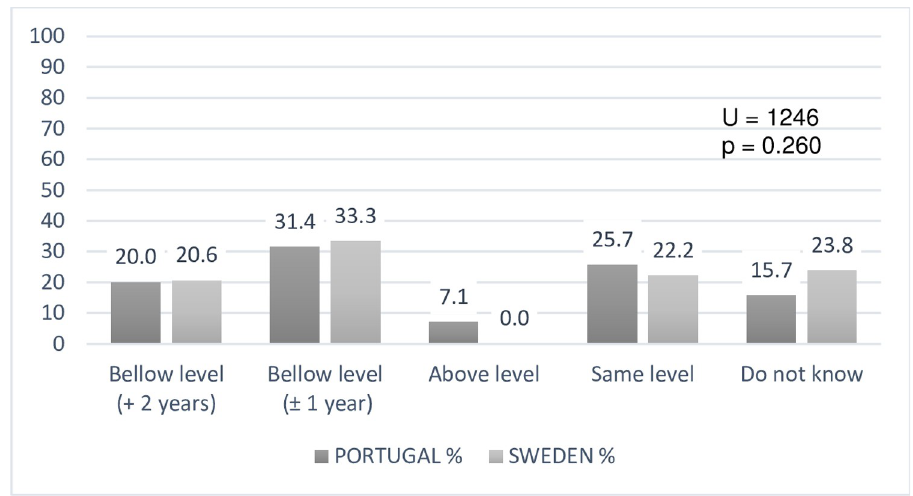
Fig 2. Teachers’ perceptions about the mathematics performance levels of DHH students (N =